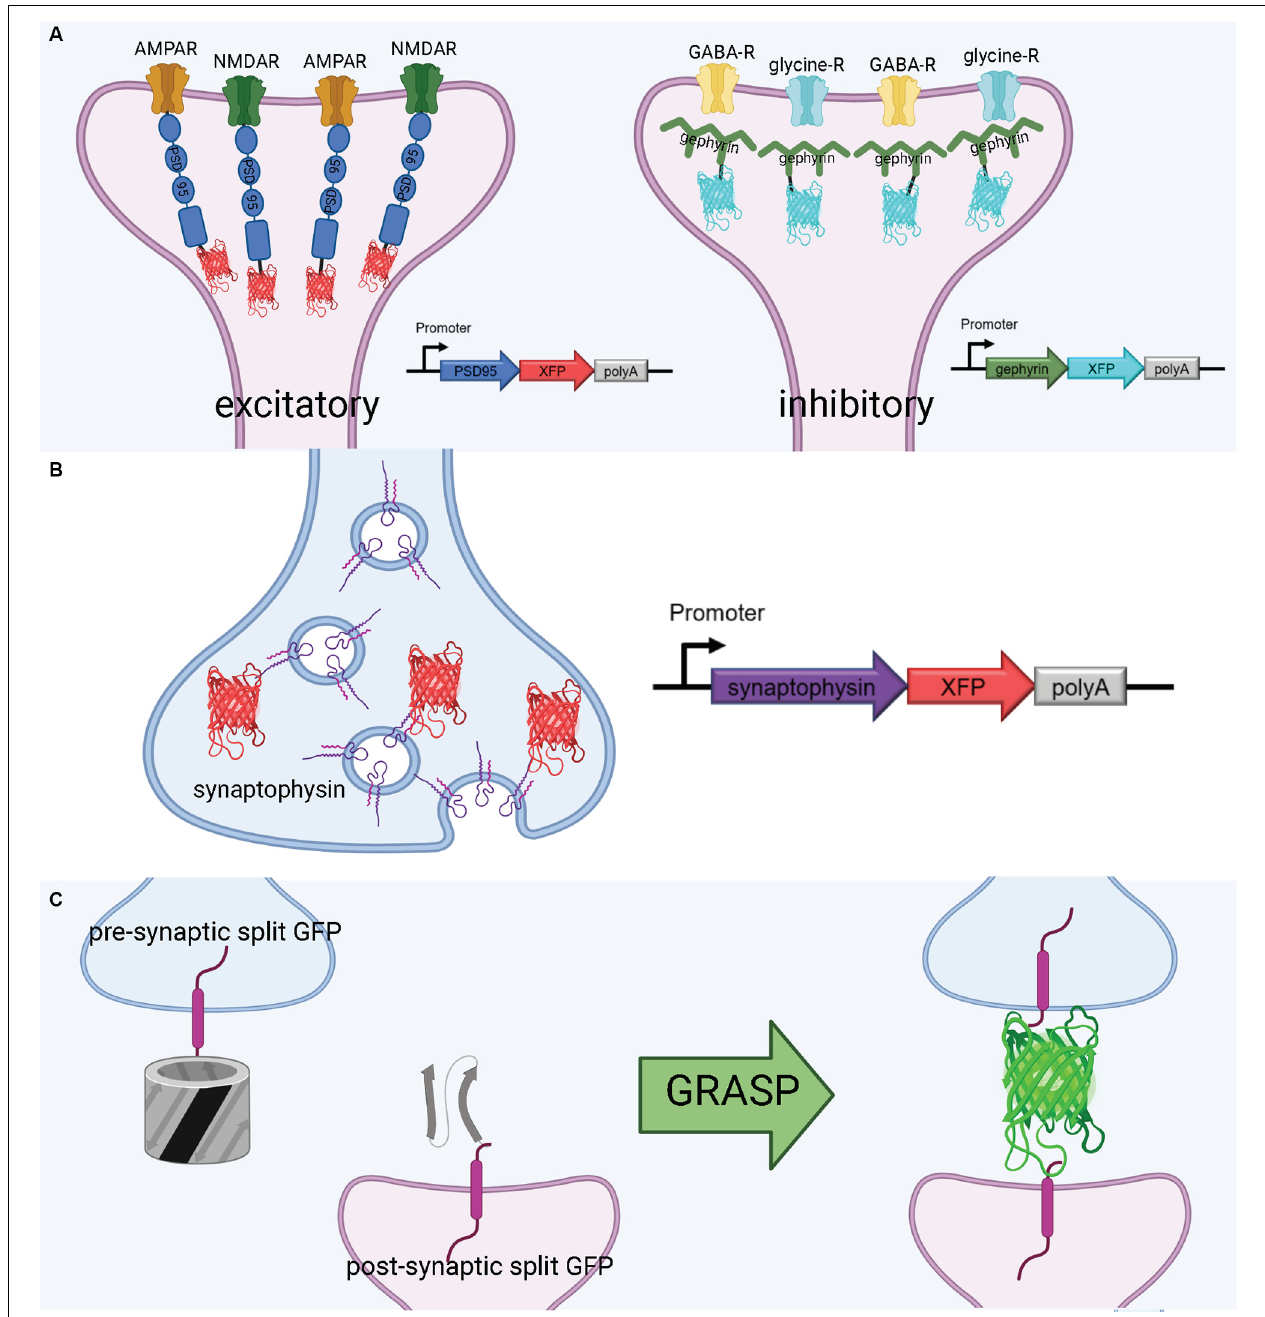
FIGURE 3 | Tools to visualize post-synaptic and pre-synaptic connections. (A) Schematic diagram of post-synaptic labeling of excitatory synapses with exogenous PSD-95-fluorescent protein hybrids and inhibitory synapses with exogenous gephyrin-fluorescent protein hybrids. (B) Schematic diagram of pre-synaptic labeling off synapses with exogenous synaptophysin-fluorescent protein hybrids. (C) Proximate synapse labeling with GFP Recombination Across Synaptic Partners (GRASP). Created with Biorender.com.